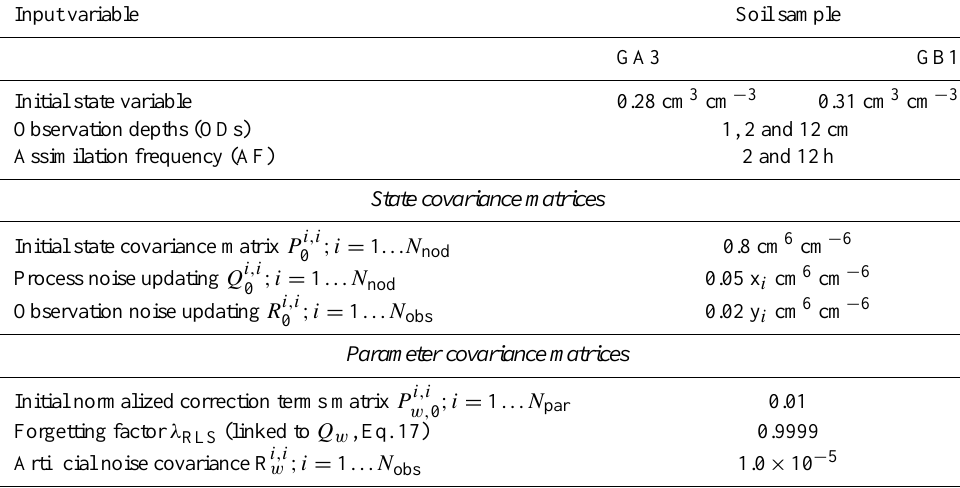
Table 2. Values adopted for the initialization and implementation of the retrieval algorithm. Input variable